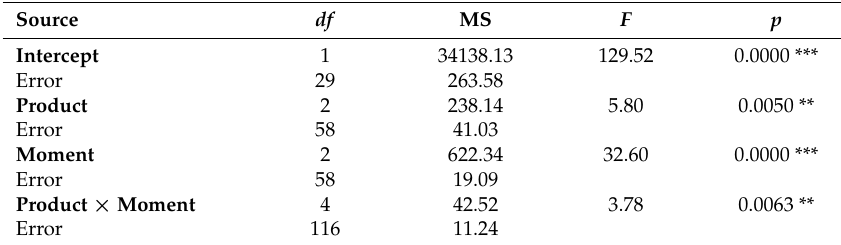
Table A4. ANOVA summary table for the Revised Minnesota Nicotine Withdrawal Scale (MNWS-R) total